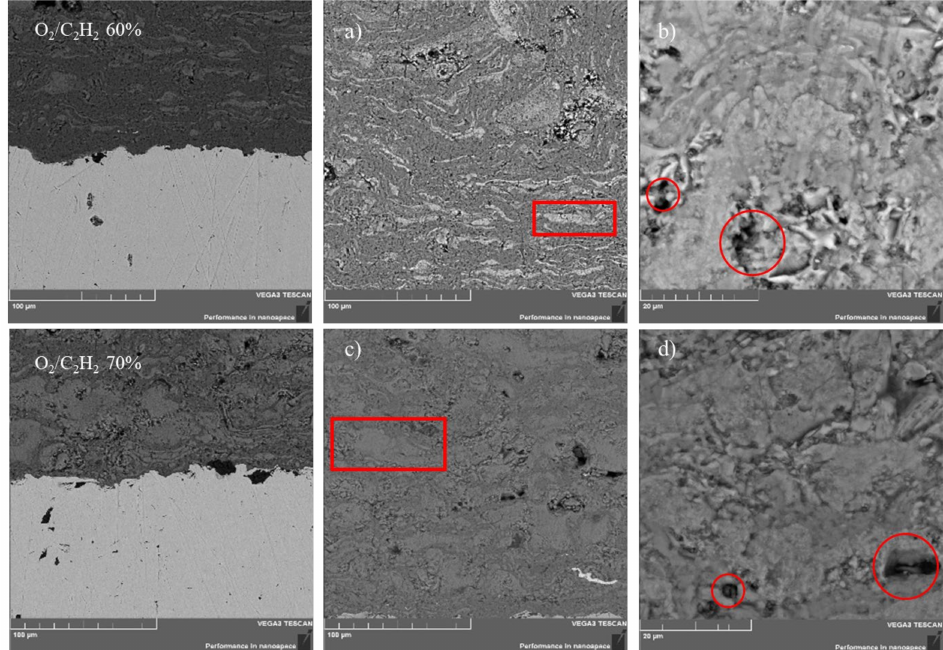
Figure 4. SEM images of the morphology of coating cross section: ( a ) Ti–Si–C 60% while 100 µ m; ( b ) Ti–Si–C 60% while 20 µ m; ( c ) Ti–Si–C 70% while 100 µ m; ( d ) Ti–Si–C 70% while 20 µ